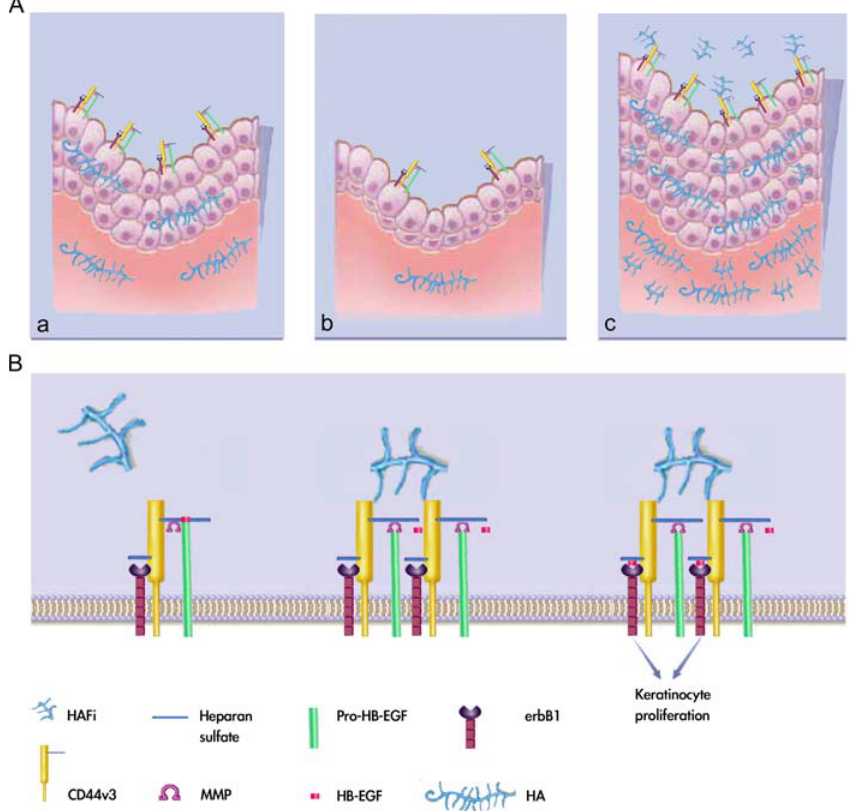
Figure 5. Hypothetical Assembly of the CD44v3/HB-EGF/erbB1 Complex and the Mechanism of HAFi-Induced Keratinocyte Proliferation (A) CD44, HA, and HB-EGF in normal skin (a), atrophic skin (b), and following treatment of atrophic skin treated with HAFi (c). (B) Schematic representation of the hypothetical assembly of the putative complex: HAFi mediates CD44v3 and heparan sulfate–bound pro-HB-EGF aggregation, resulting in the recruitment and activation of an MMP/ADAM. Pro-HB-EGF is cleaved by the MMP/ADAM, and the resulting active moiety binds and activates erbB1, generating proliferation signals.